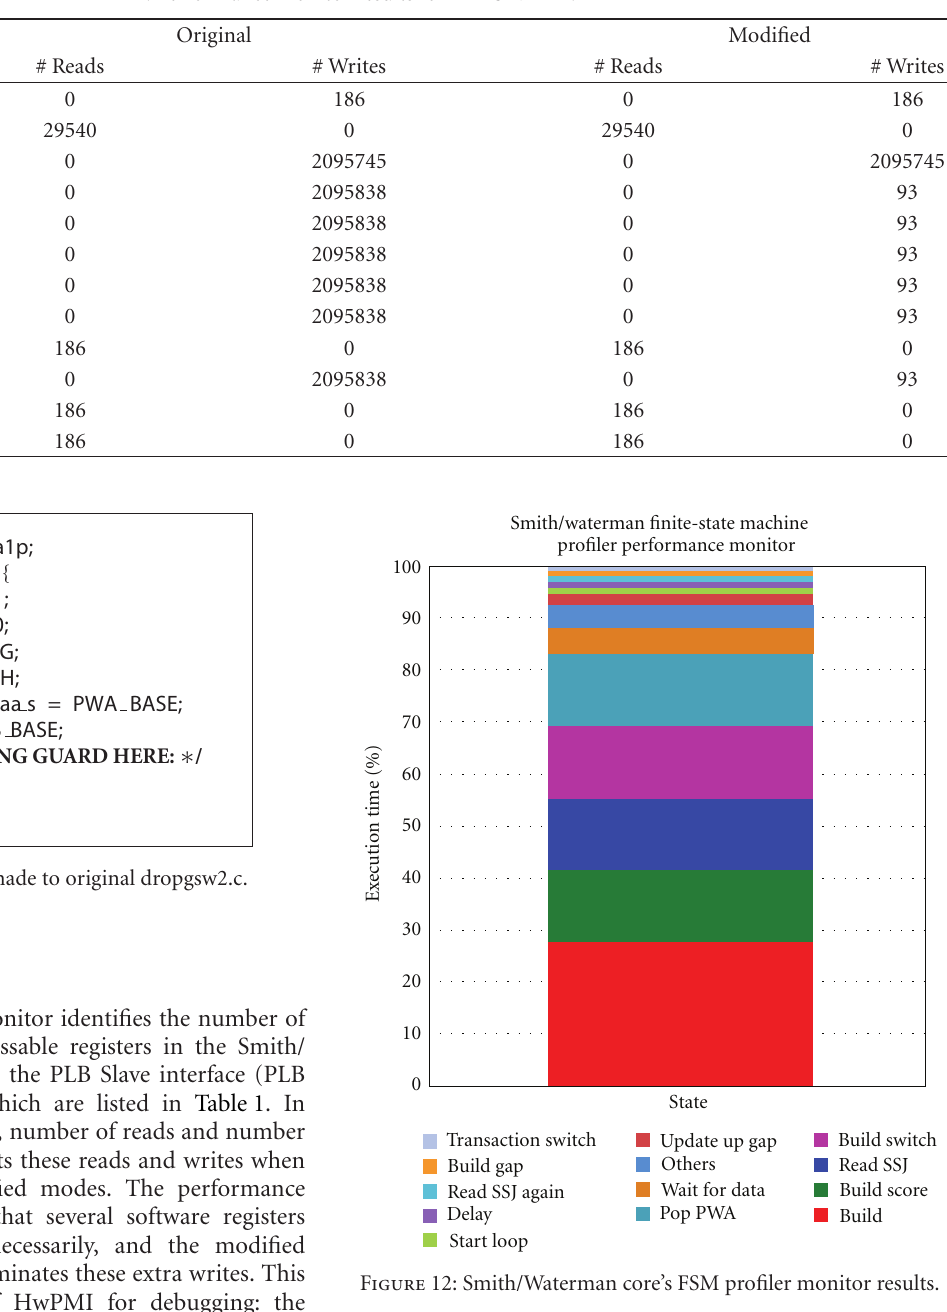
Table 1: Performance monitor results for PLB SLV IPIF.